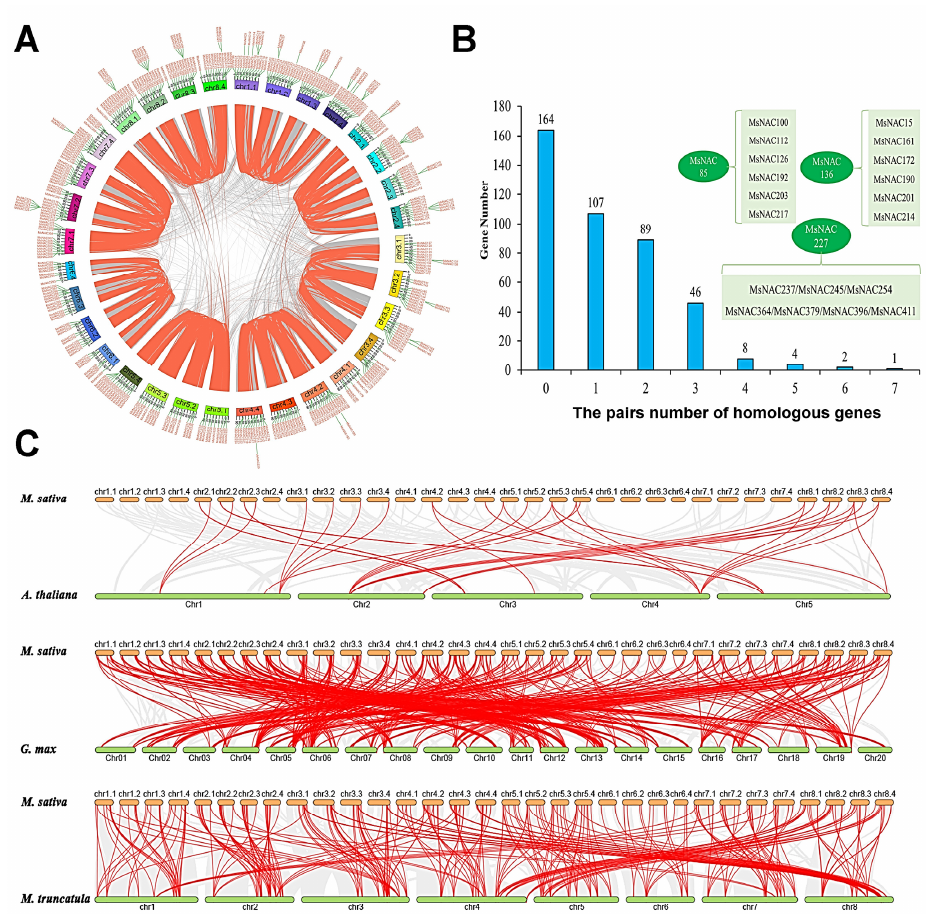
Figure 4. Duplication event analysis for the MsNAC gene family in the M. sativa genome and synteny analysis between alfalfa and the other three plant species. ( A ), The duplication events in the M. sativa genome; colored lines indicate MsNAC family members. ( B ), Statistical analysis of the duplication events; three duplication events ( MsNAC85 , MsNAC136 and MsNAC227 ) are displayed. ( C ), Collinearity analysis between M. sativa and A. thaliana , G. max and M. truncatula . The colored lines indicate the NAC family members in different